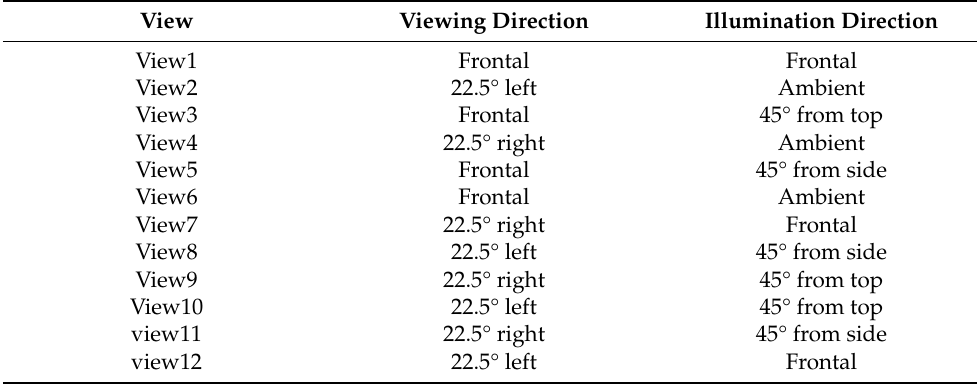
Table 1. Viewing and illumination conditions of selected views from KTH-TIPS2 [42]